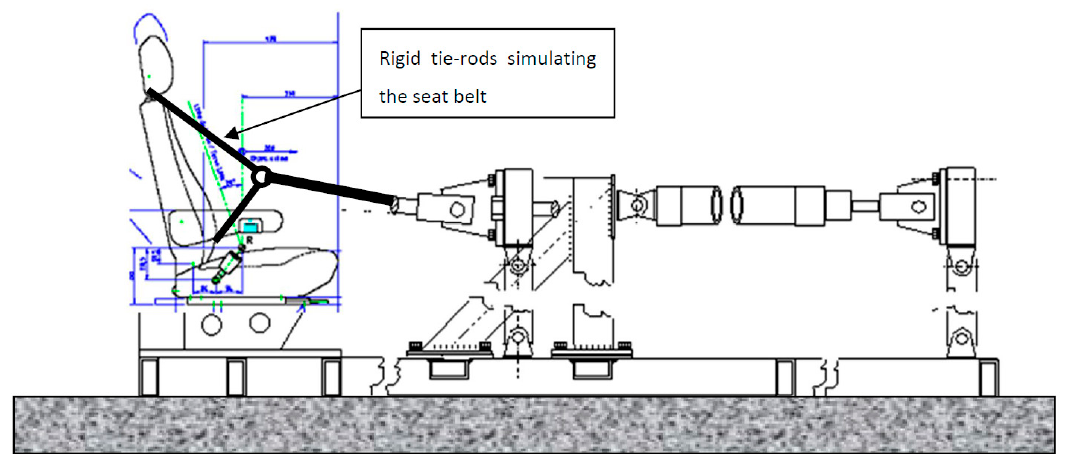
Figure 8. Pseudo-dynamic test rig for structural validation of bus passenger seats (figure not included in the work of Pinto et al. [12]).